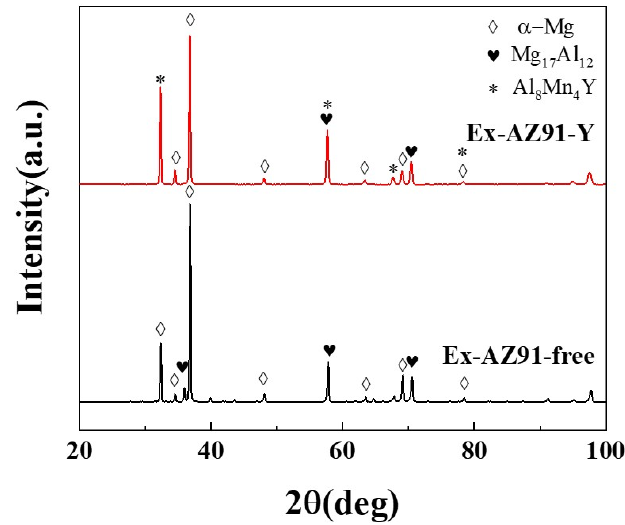
Figure 5. X-ray diffraction spectrum of Ex-AZ91 alloy before and after adding Y.